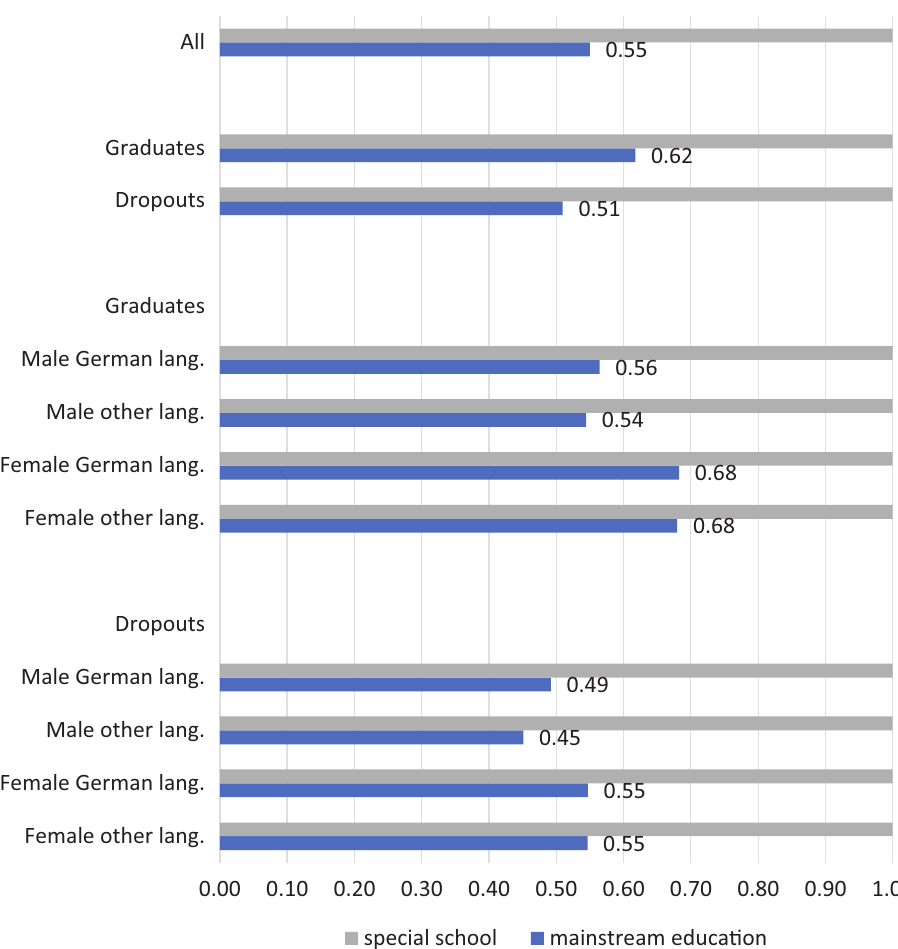
Figure 1. Odds‐ratios for becoming NEET according to the former setting (n = 18,065). Source: Statistik Austria (2021, 13–18 years